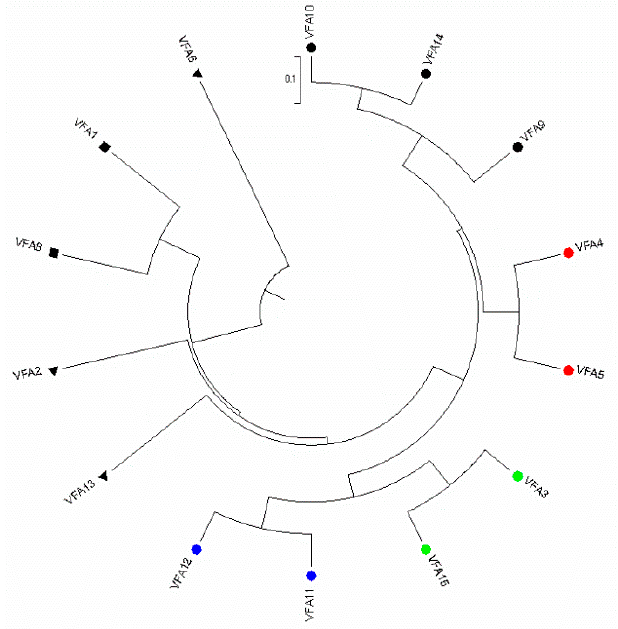
Figure 3. Unweighted pair-group method of arithmetic averages (UPGMA) dendrogram of the 14 Algerian Faba bean accessions based on SSR data ( ● , Cluster I-Sb1; ● , Cluster I-Sb2; ● , Cluster I-Sb3; ● , Cluster I-Sb4; , Cluster II; , outgroups).